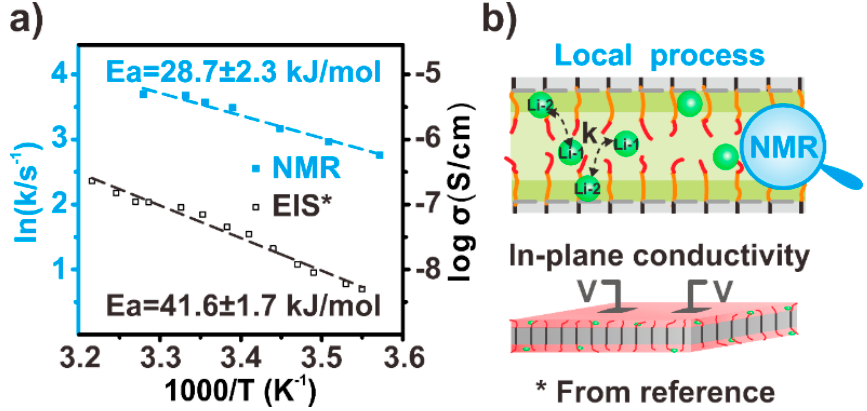
Figure 7. ( a ) Blue square: the Arrhenius plot of the exchange rates obtained from the temperature ‐ dependent 2D 7 Li– 7 Li exchange NMR. Black open square: the Arrhenius plot of the conductivities reprinted (adapted) with permission from [31]. Copyright (2014) American Chemical Society. ( b ) Top: schematic of the local exchange process of Li + ion. Bottom: the conductivity measurement of the crystal surface with a similar material as Li et al. (reprinted (adapted) with permission from [31]. Copyright (2014) American Chemical Society.). The orange lines and red lines denote the PEO amorphous chain segments and chain ends, respectively. The black lines denote the crystalline PEO chains, and the green balls denote the Li + ions. The pink flat denotes the surface of PEO crystal.